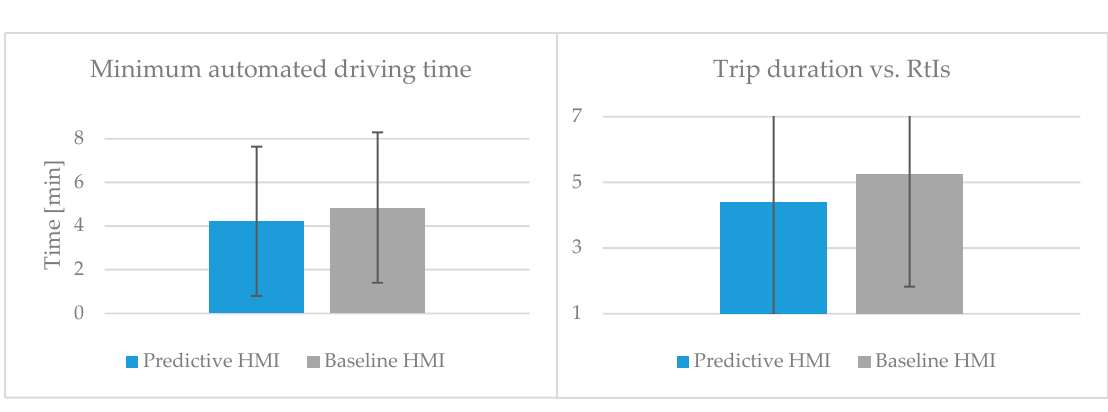
Figure 11. Desired minimum automated driving duration and willingness to accept longer trip durations for less interruptions (7-Likert).